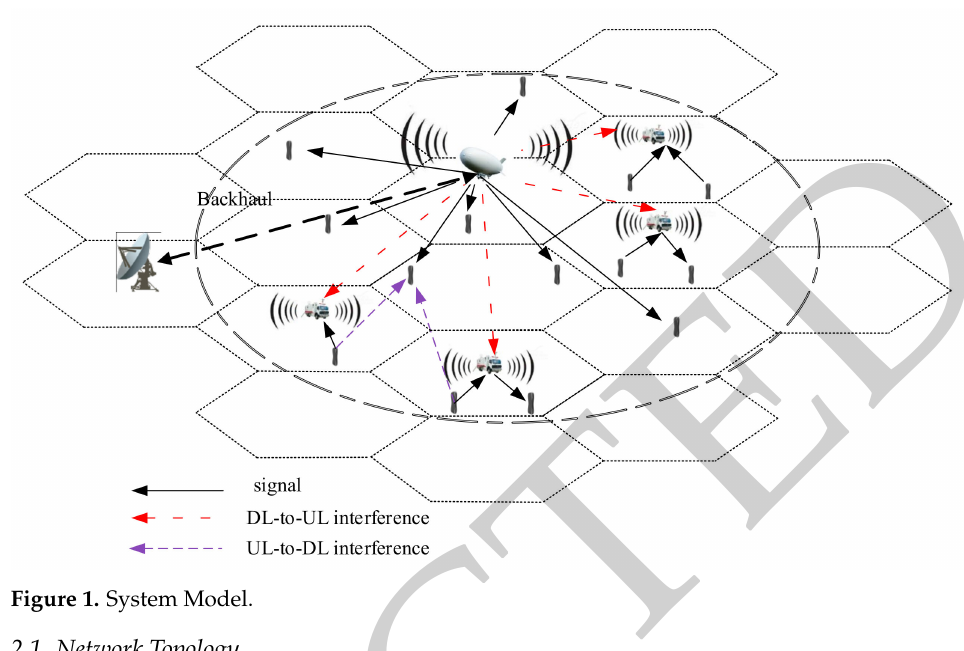
Figure 1. System